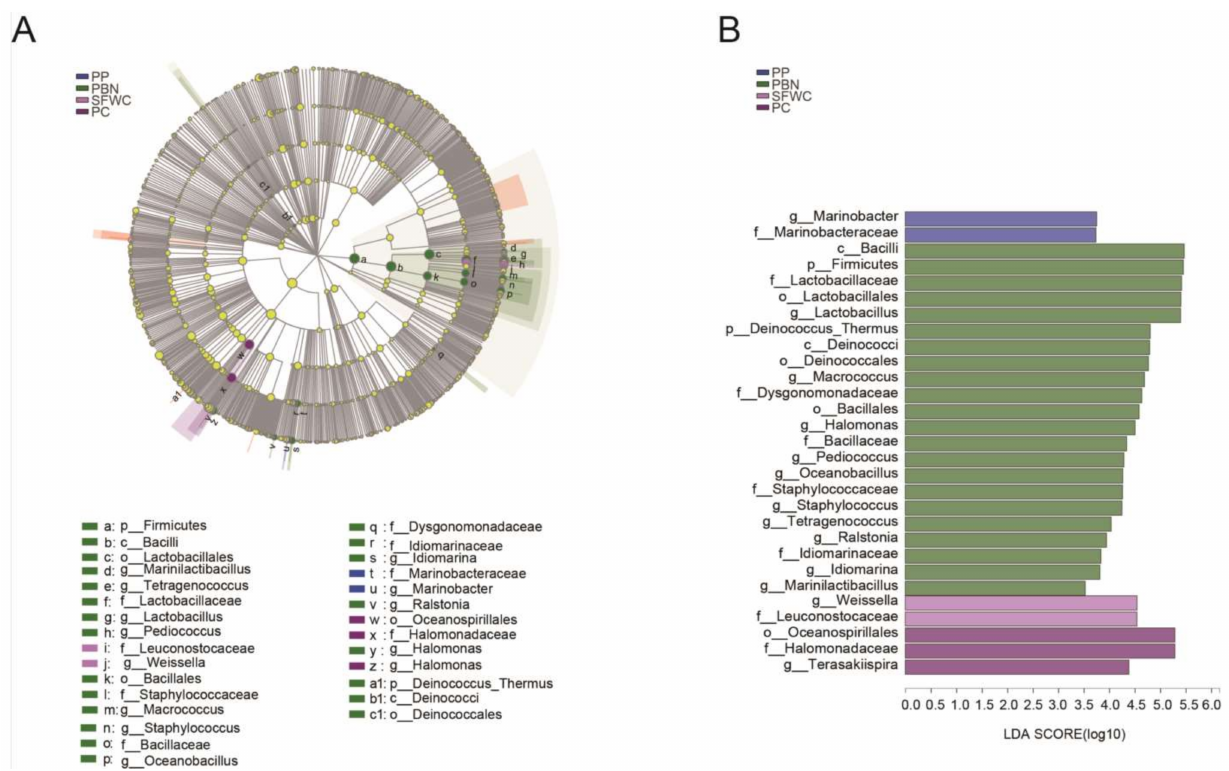
Figure 5. LEfSe comparison of bacterial communities among four traditional fermented vegetables samples. ( A ) Cladogram representing the abundance of those taxa in these four fermented vegetables. ( B ) Histogram of the results of the microbiota in these four fermented vegetables with a threshold value of